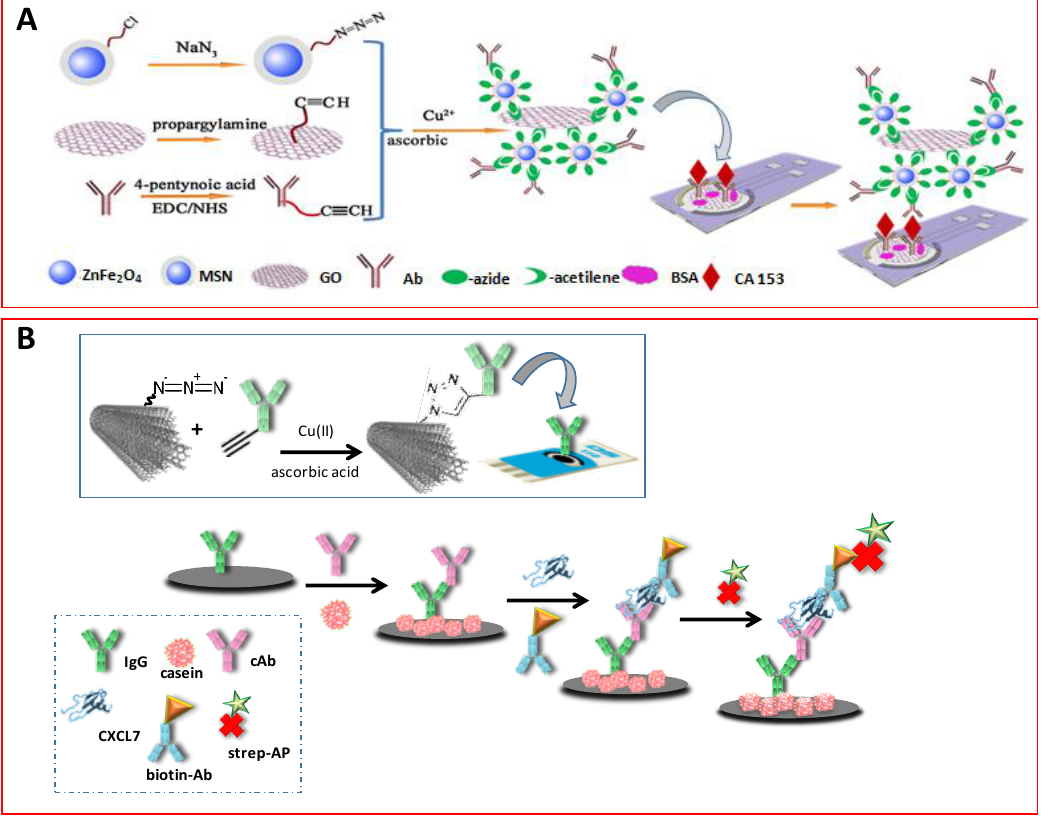
Figure 12. Schematic illustrations of the steps involved in the preparation of electrochemical immunosensors for CA 153 ( A ) and CXCL7 ( B ). See text for details. Reprinted from [60] ( A ) and [79] ( B ) with permission.